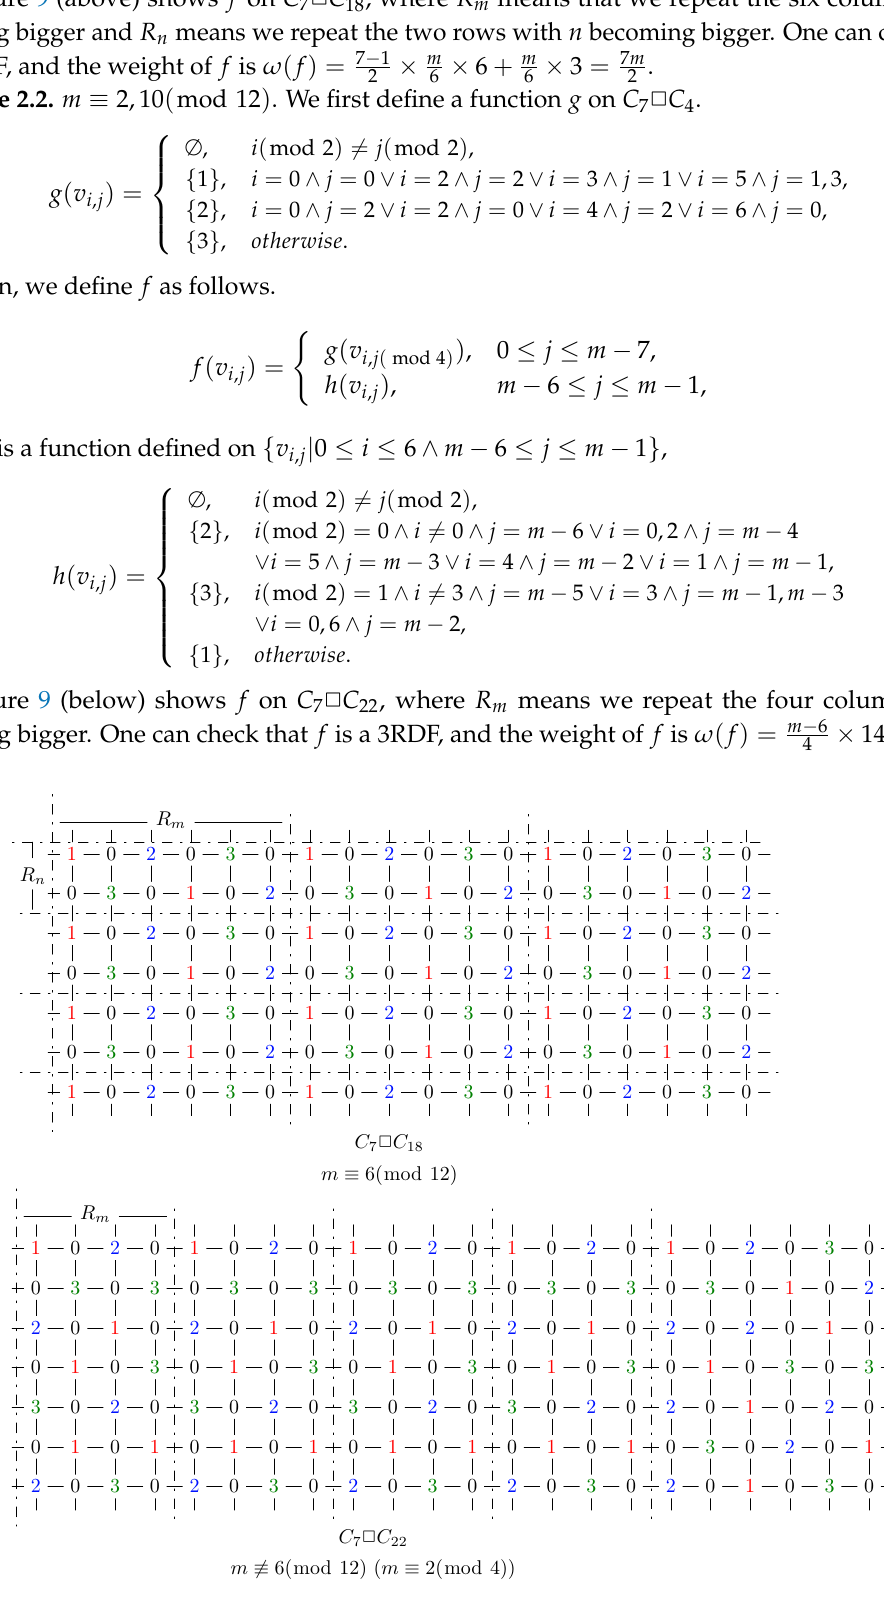
Figure 9. 3RDFs on C 7 2 C 18 and C 7 2 C 22